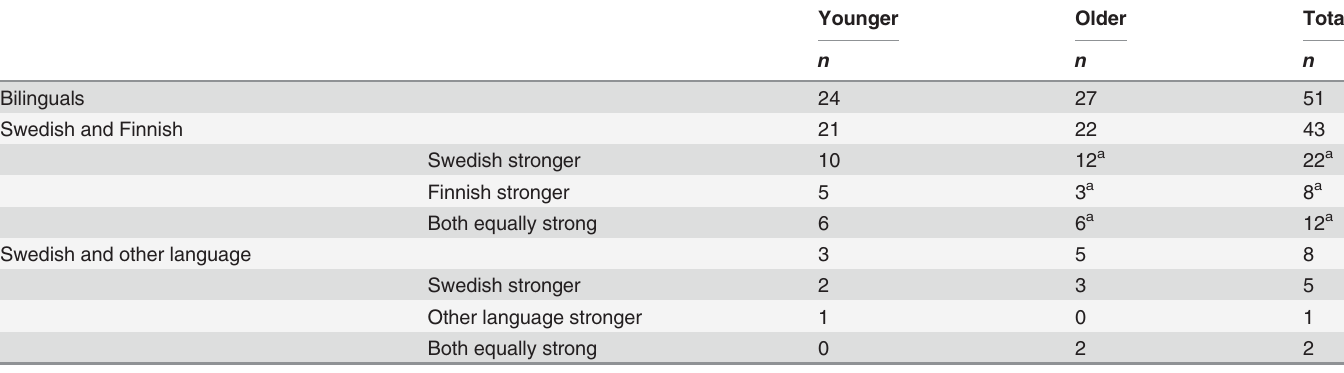
Table 1. Language abilities of the bilingual